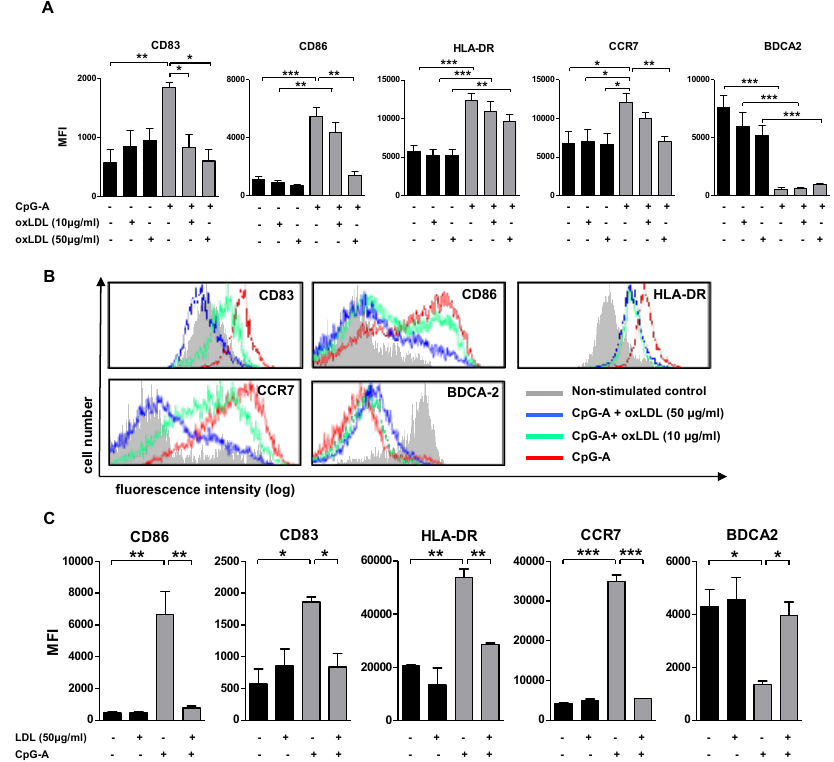
Figure 1. OxLDL inhibits CpG-induced expression of maturation markers by pDCs. Freshly isolated human pDCs were stimulated with 2.5 µ M CpG-A in the absence or presence of lipoproteins; oxLDL and CpG-A were added simultaneously. Non-stimulated pDCs with or without oxLDL were used as control. After 24 h, cells were harvested, and the surface expression levels of the indicated markers were measured by flow cytometry. ( A ) Induction of pDC maturation markers (CD83, CD86, HLA-DR, CCR7, BDCA2) expressed as MFI. Exposure to oxLDL (10 and 50 µ g/mL) dose-dependently reverses the CpG-A induced up-regulation of pDC maturation markers. ( B ) Maturation marker expression on non-stimulated pDCs (grey), CpG-A stimulated pDCs (2.5 µ M; red) or CpG-A (2.5 µ M) plus oxLDL stimulated pDCs (10 µ g oxLDL/mL, green; 50 µ g oxLDL/mL, blue). ( C ) Coincubation of pDCs with LDL (50 µ g/mL) reverses CpG-A induced changes in pDC maturation marker expression. Data are shown as mean ± SEM of five independent experiments using different donor pDCs. * p < 0.05, ** p < 0.01, *** p <